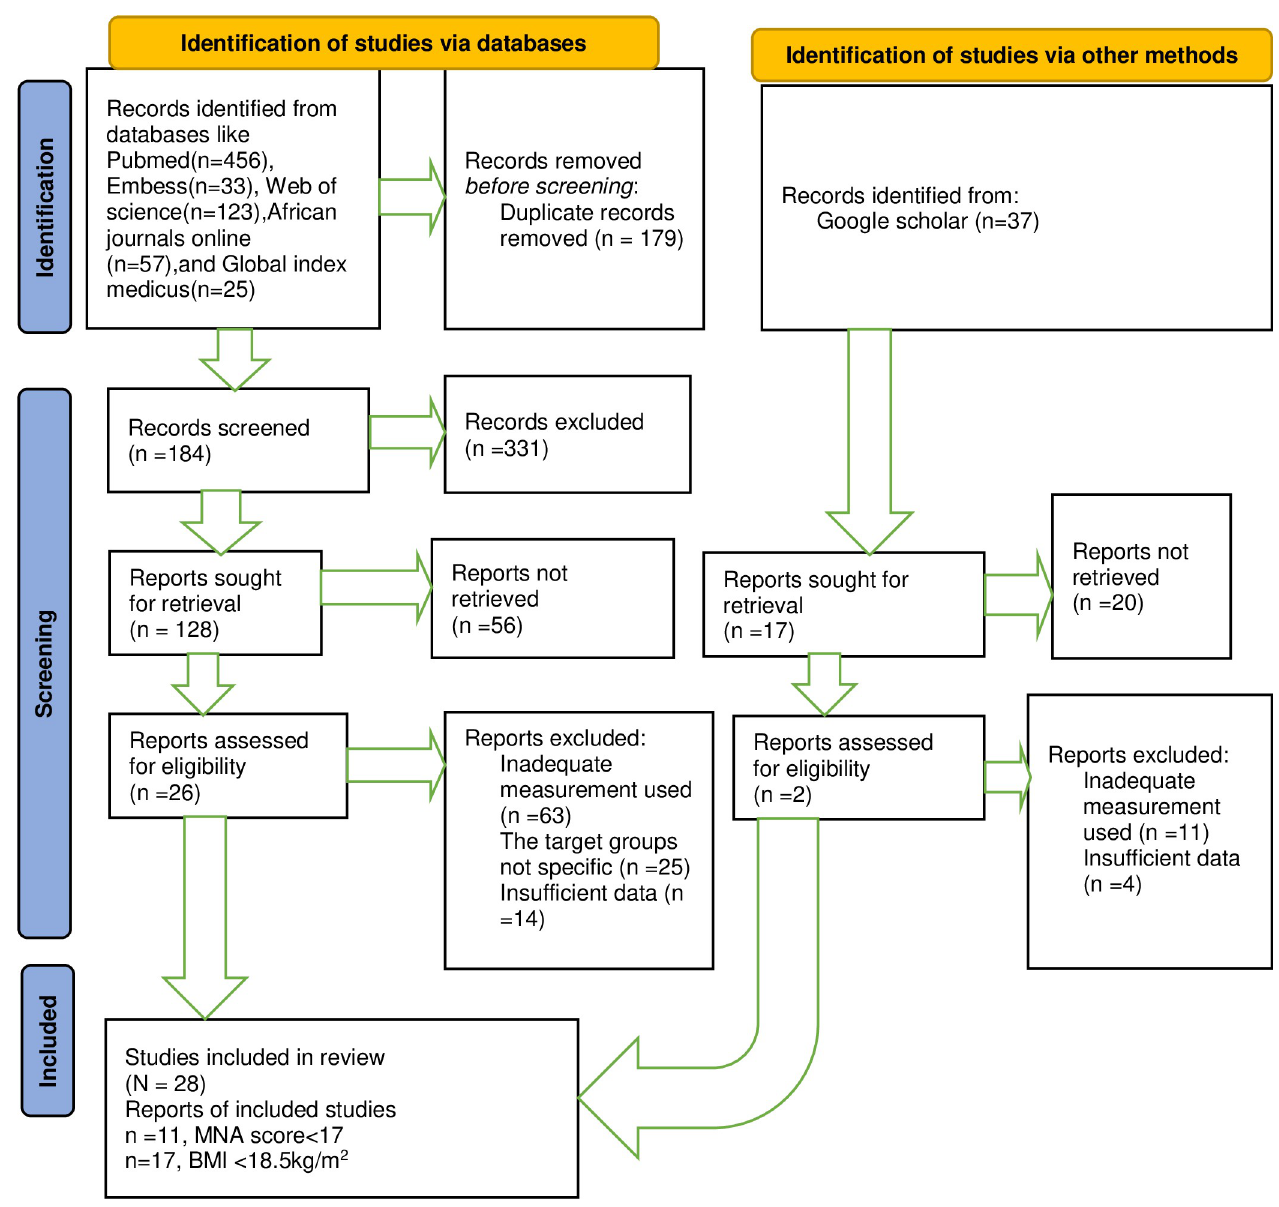
Fig 1. A PRISMA flow diagram for systematic reviews, met analysis and meta-regression of included studies.